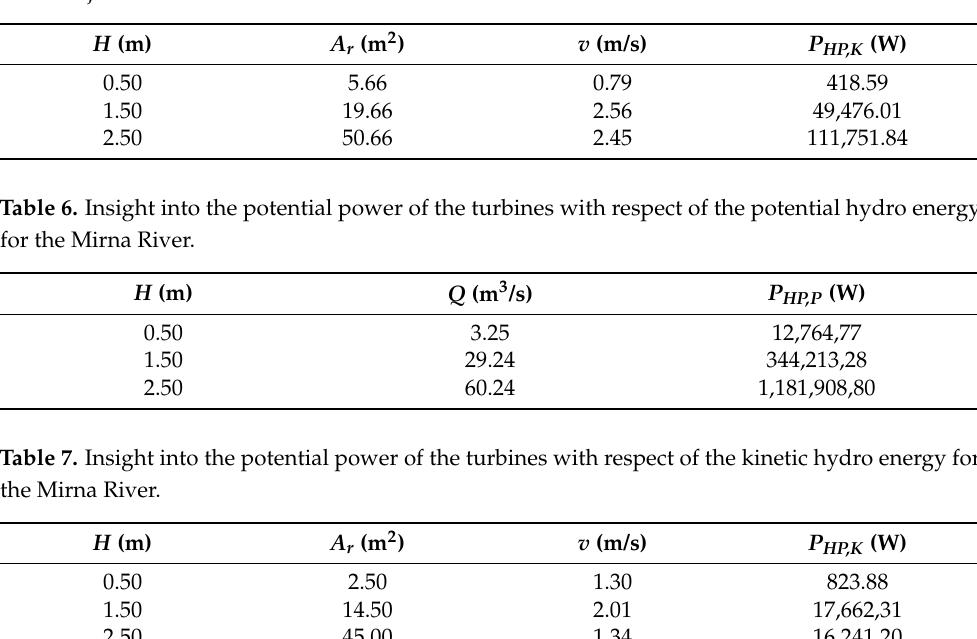
Table 5. Insight into the potential power of the turbines with respect of the kinetic hydro energy for the Gornja Dobra River.